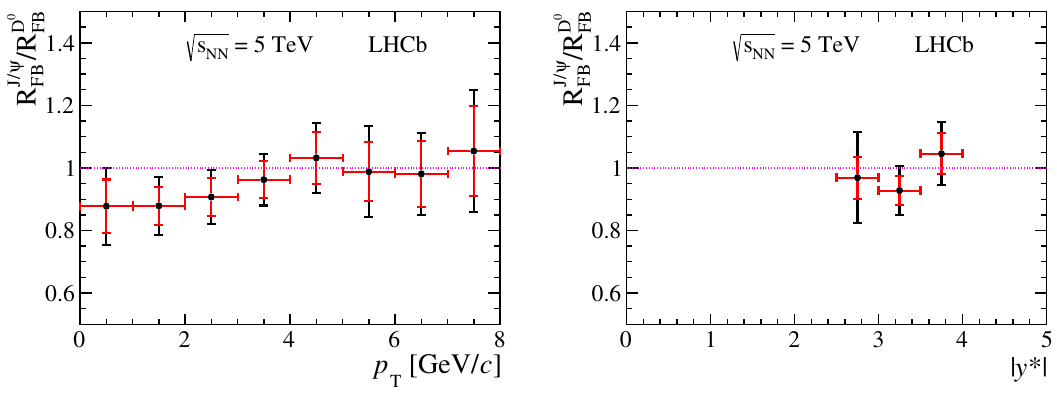
Figure 9 . Relative forward-backward production ratio R FB for prompt D 0 mesons over that for prompt J= mesons (left) as a function of p T integrated over the common rapidity range 2 : 5 < j y (cid:3) j < 4 : 0 for p T < 6 GeV =c and over 2 : 5 < j y (cid:3) j < 3 : 5 for 6 < p T < 10 GeV =c ; (right) as a function of y (cid:3) integrated up to p T = 10 GeV =c . The red inner bars in the uncertainty represent the statistical un- certainty and the black outer bars the quadratic sum of the statistical and systematic